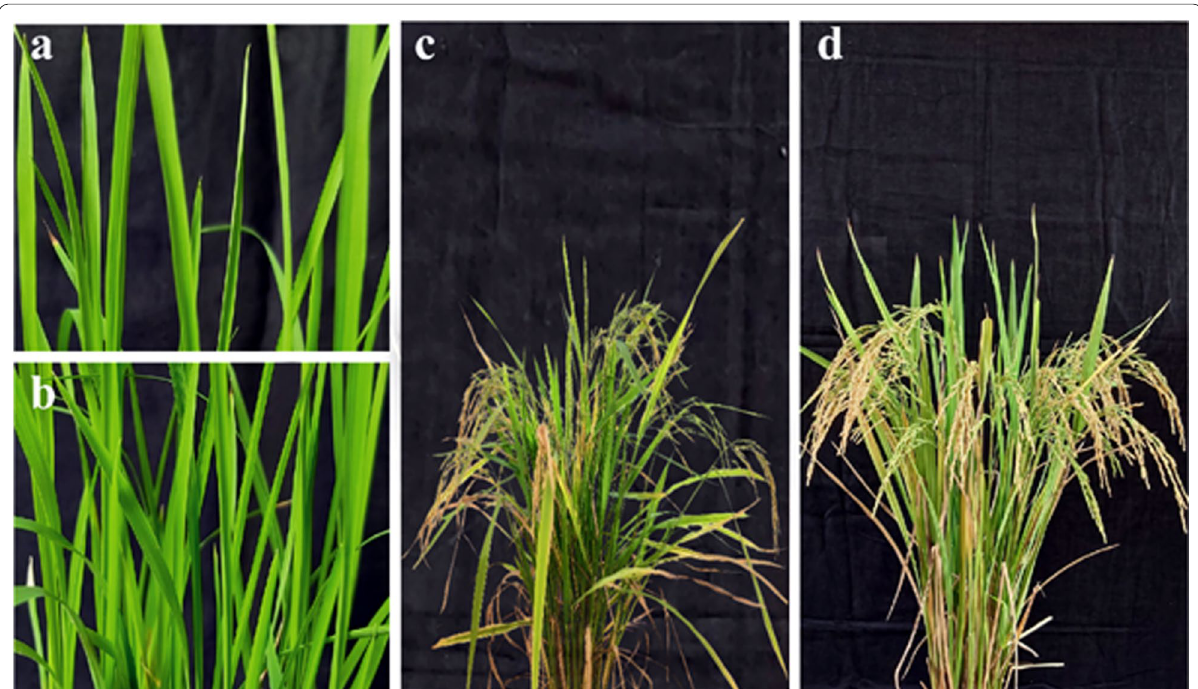
Fig. 4 Inoculation of rice cv. BRRI dhan63 with two MoT strains viz. BTJP4‑5 and BTMaU(10b) developed no blast disease symptoms on the leaves and panicles. a , c No blast disease symptoms in rice leaves and panicles artificially inoculated by the conidia of MoT strain BTJP4‑5. b , d No blast disease symptoms in artificially inoculated rice plants with MoT strain